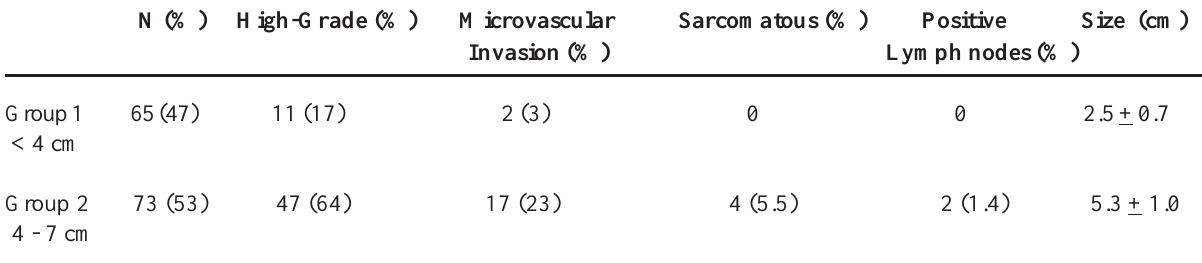
Table 1 – Characteristics of